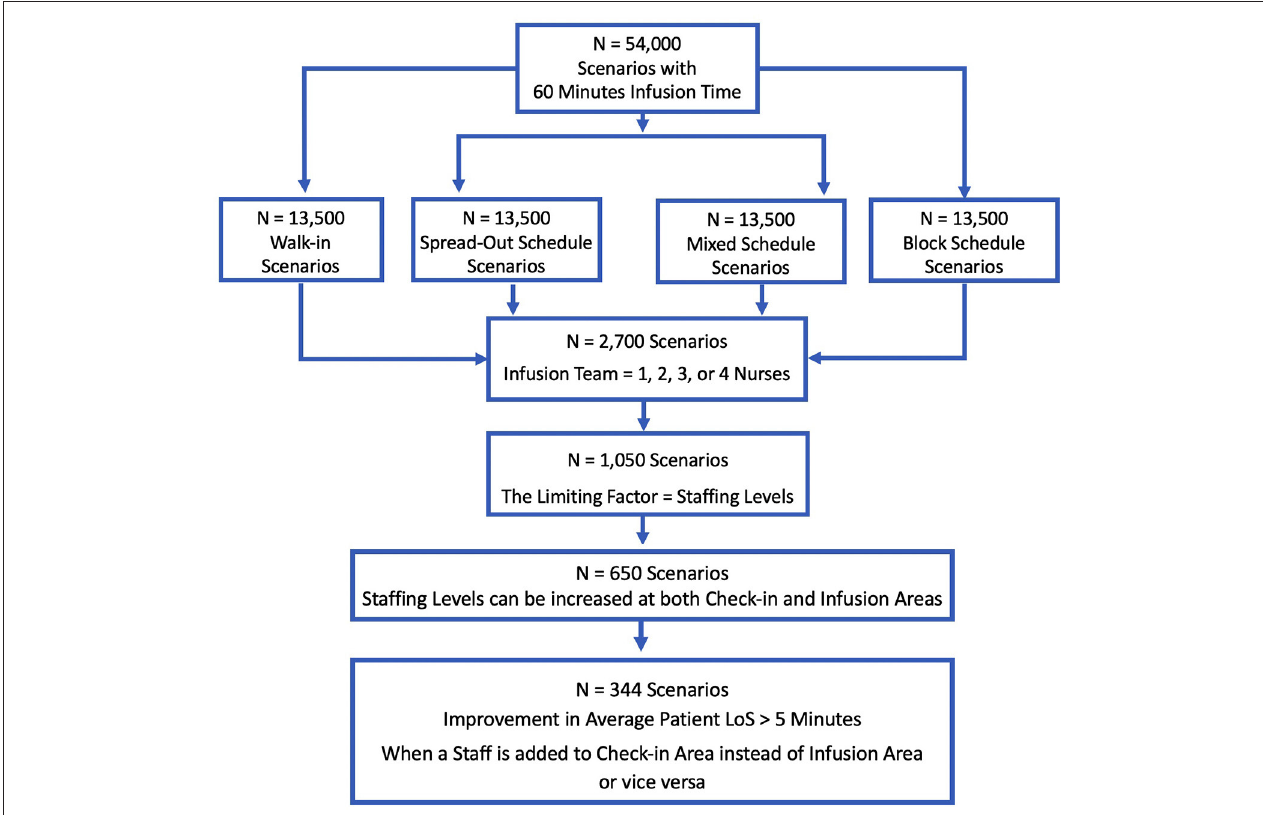
FIGURE 6 | CONSORT diagram - the number of scenarios included in staff adjustment